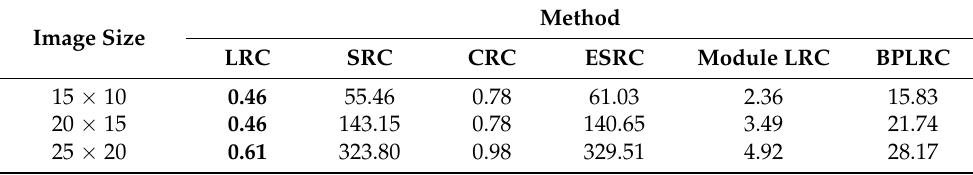
Table 2. Computational time (seconds) for different methods to identify 300 images. Image